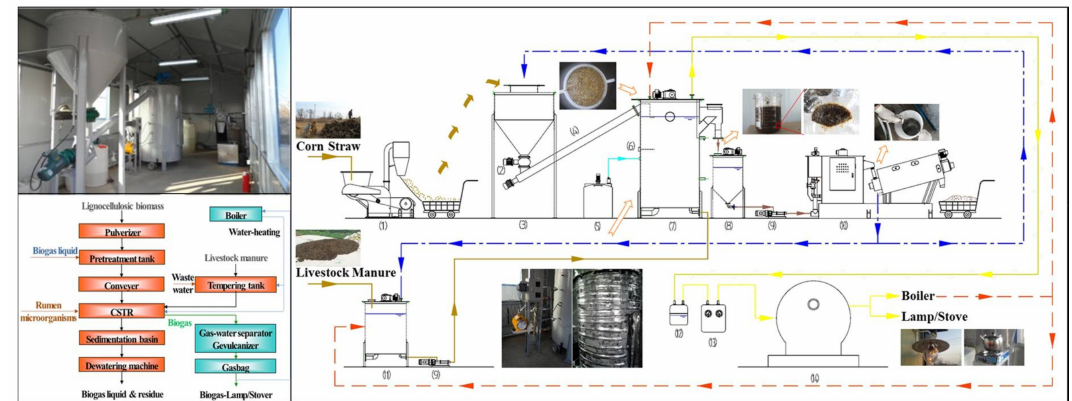
Figure 8. The flow and schematic diagram of the technical system including: ( 1 ) pulverizer, ( 2 ) unloader, ( 3 ) pretreatment tank, ( 4 ) conveyer, ( 5 ) pH adjustment bucket, ( 6 ) pH meter, ( 7 ) CSTR, ( 8 ) sedimentation basin, ( 9 ) screw pump, ( 10 ) screw type sludge dewatering machine, ( 11 ) tempering tank, ( 12 ) gas–water separator, ( 13 ) devulcanizer, and ( 14 ) gasbag. Pathway of substrates ( ), digestate ( ), pH adjustment ( ), biogas ( ), biogas liquid ( ), and water-heating (